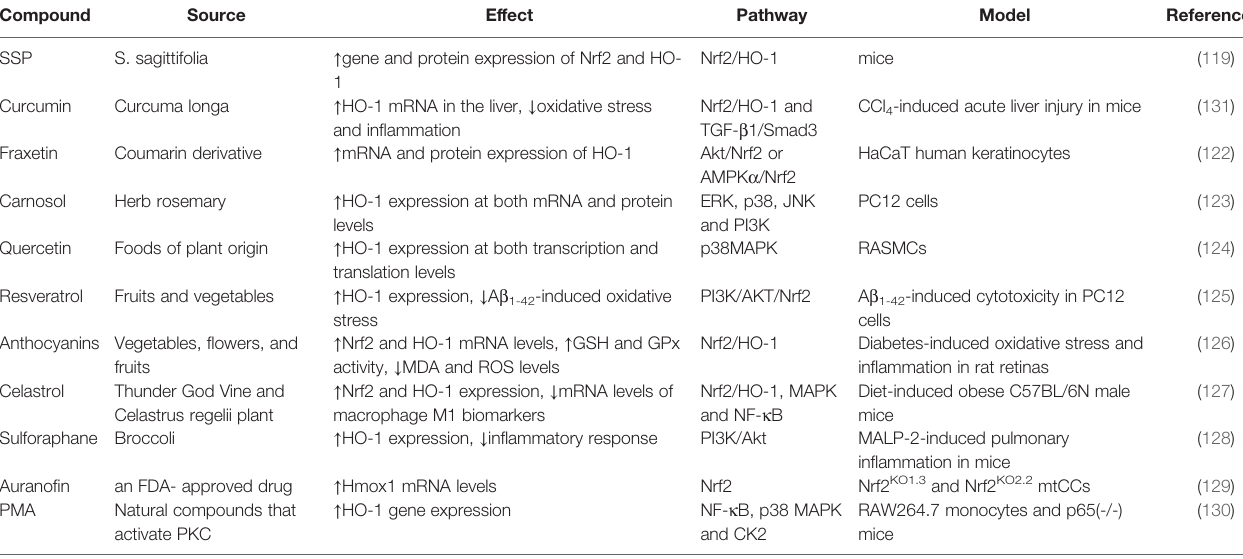
TABLE 1 | Natural source, evaluated model of diseases, reported effect, and pathway of natural compounds and drugs.